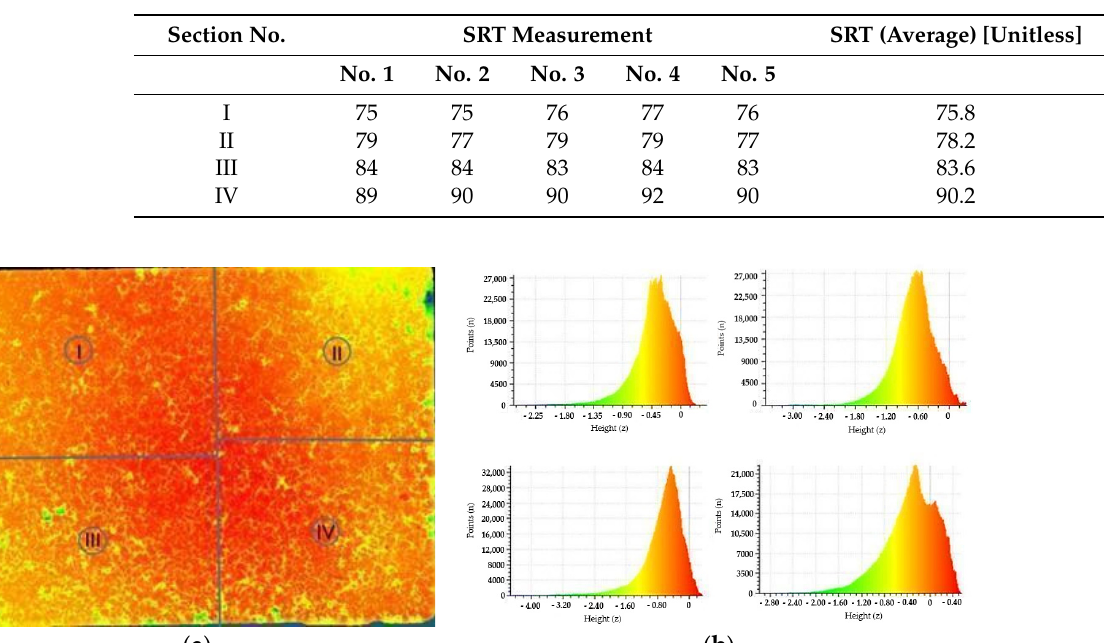
Table 4. Skid resistance measuring results.